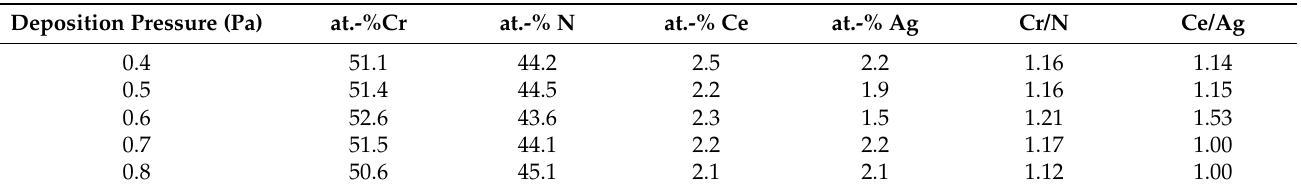
Table 1. Chemical compositions of the CrAgCeN coatings deposited under different deposition